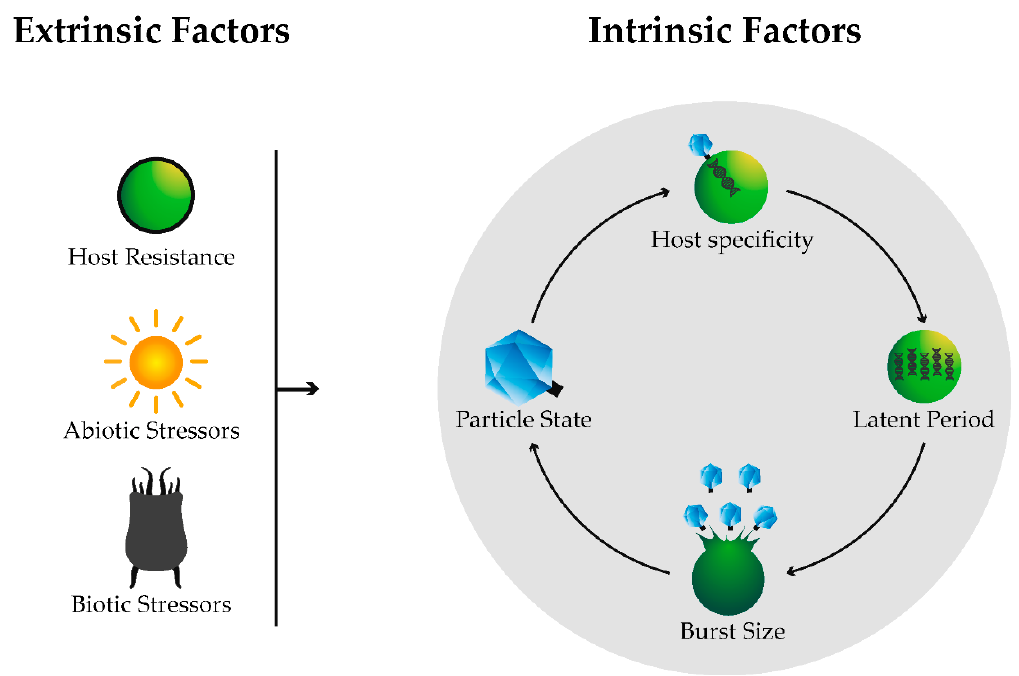
Figure 1. Intrinsic and extrinsic factors that can make viruses unsuccessful during their life cycle stages. Host specificity refers to the attachment and insertion of genetic material (DNA or RNA) into the hosts, latent period refers to the duration of the viral infection within the host during which virus particles are produced, burst size refers to the number of viral progeny released and particle state refers to the state where viruses are not within a host. Extrinsic factors are divided into host resistance mechanisms, abiotic and biotic stressors, and they can affect viruses during any of their life stages.